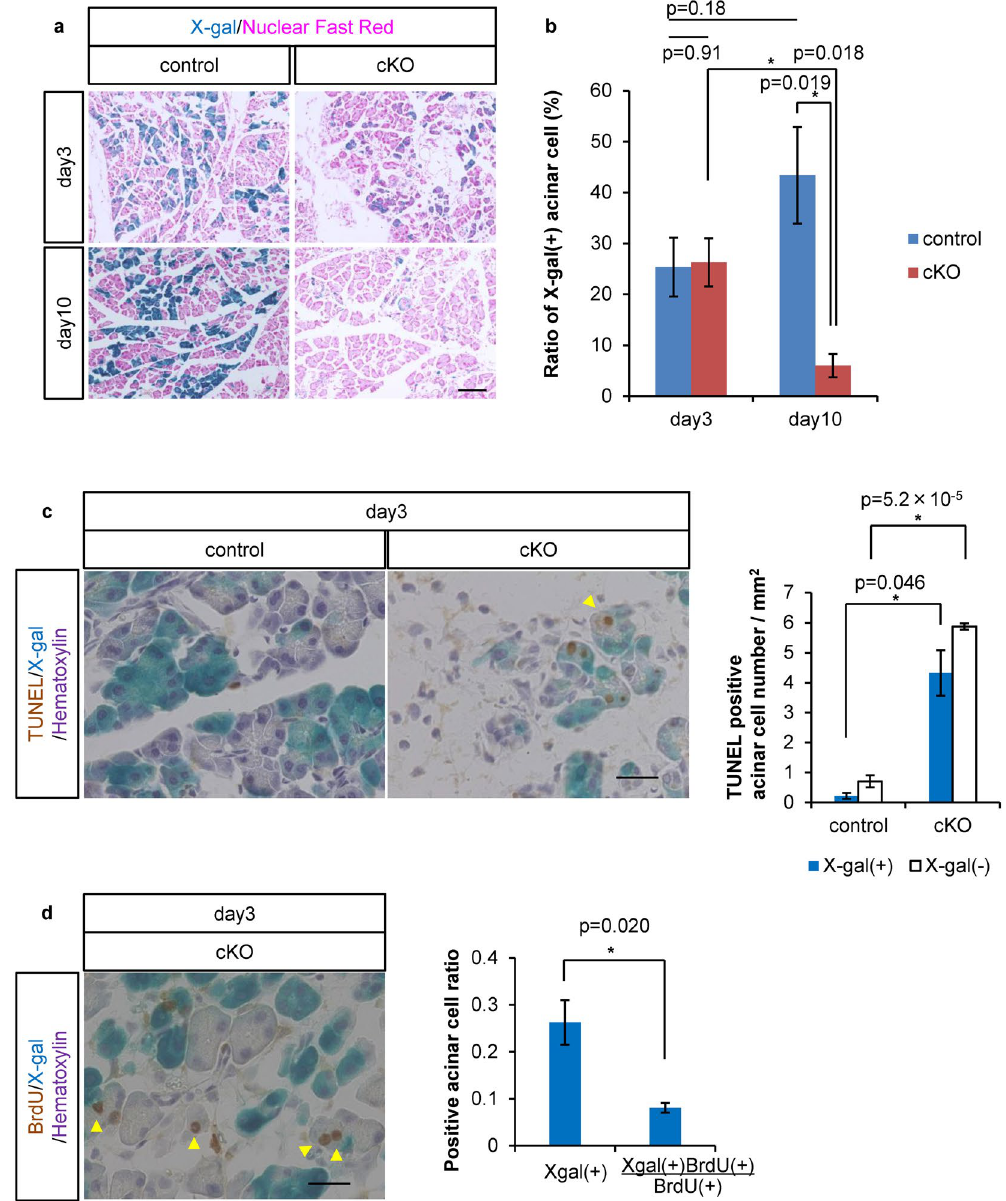
Figure 2. Lineage tracing revealed activated apoptosis and compensatory proliferation in Ptf1a cKO pancreata. ( a ) Representative figures of control and Ptf1a cKO mice on day 3 and day 10 stained by X-gal and Nuclear Fast Red. ( b ) The ratio of X-gal labeled acinar cells. control, n = 3; Ptf1a cKO, n = 3. ( c ) Representative figures of TUNEL staining with X-gal and hematoxylin staining, and the number of TUNEL( + ) acinar cells per mm 2 on day 3. ( d ) Representative figure of BrdU staining with X-gal and hematoxylin staining, and the ratio of X-gal( + ) BrdU( + ) cells per total BrdU( + ) cells compared with the ratio of X-gal( + )cells in Ptf1a cKO mice on day 3. Arrowheads indicate an X-gal( − )TUNEL( + ) nucleus in ( c ) or X-gal( − )BrdU( + ) nuclei in ( d ) in Ptf1a cKO mice. Scale bars = 100 μ m ( a ) or 25 μ m ( c , d ). * P <